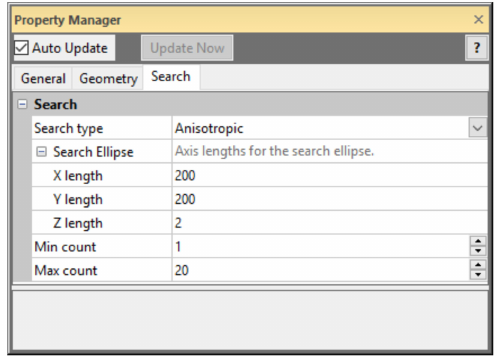
Figure 10. Specified sample selection parameters for 3D gridding (object “Gridder”) taken from the initialization file.